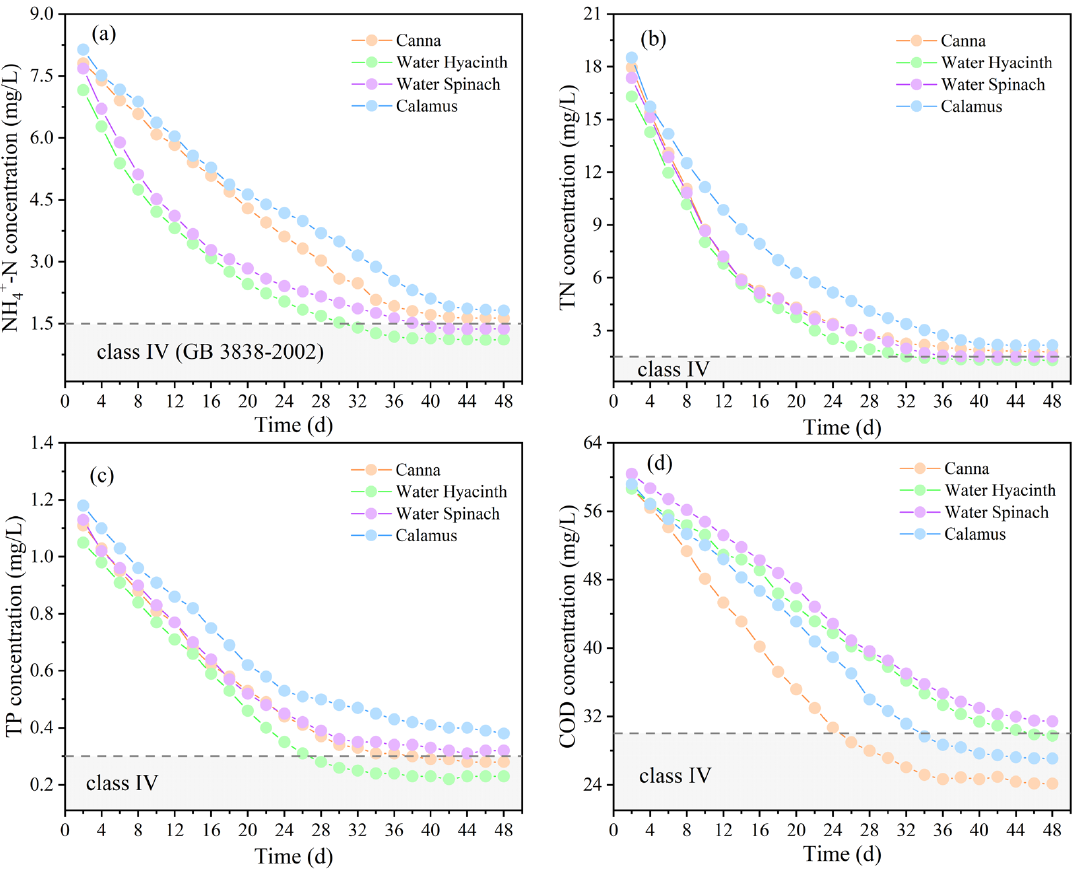
Figure 1. Comparison of contaminants removal of plant islands with different plants: ( a ) NH 4 + -N, ( b ) TN, ( c ) TP, ( d ) COD .